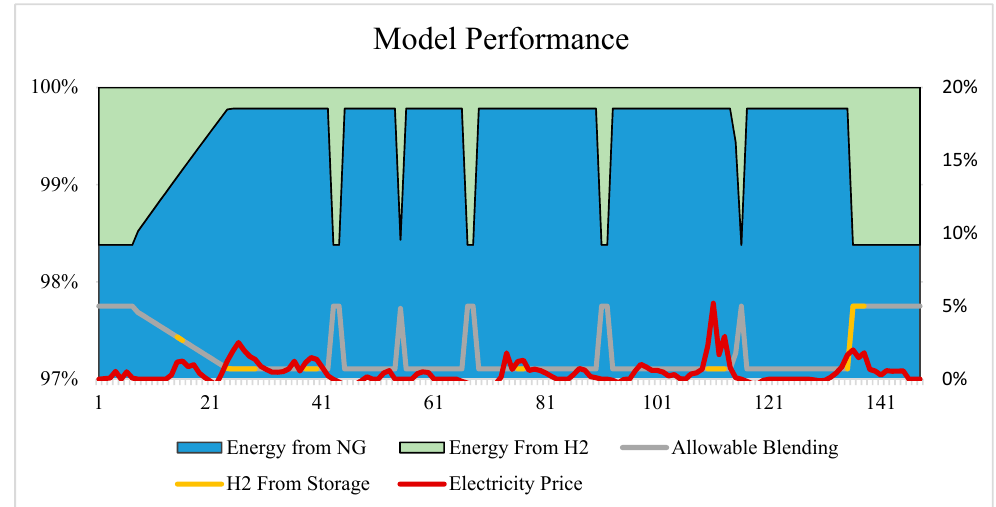
Figure 3. Two-week period of the model’s operation, showing ability to select the appropriate blending percentage, as well as when to utilize stored vs. generated hydrogen based on the overlay of HOEP.